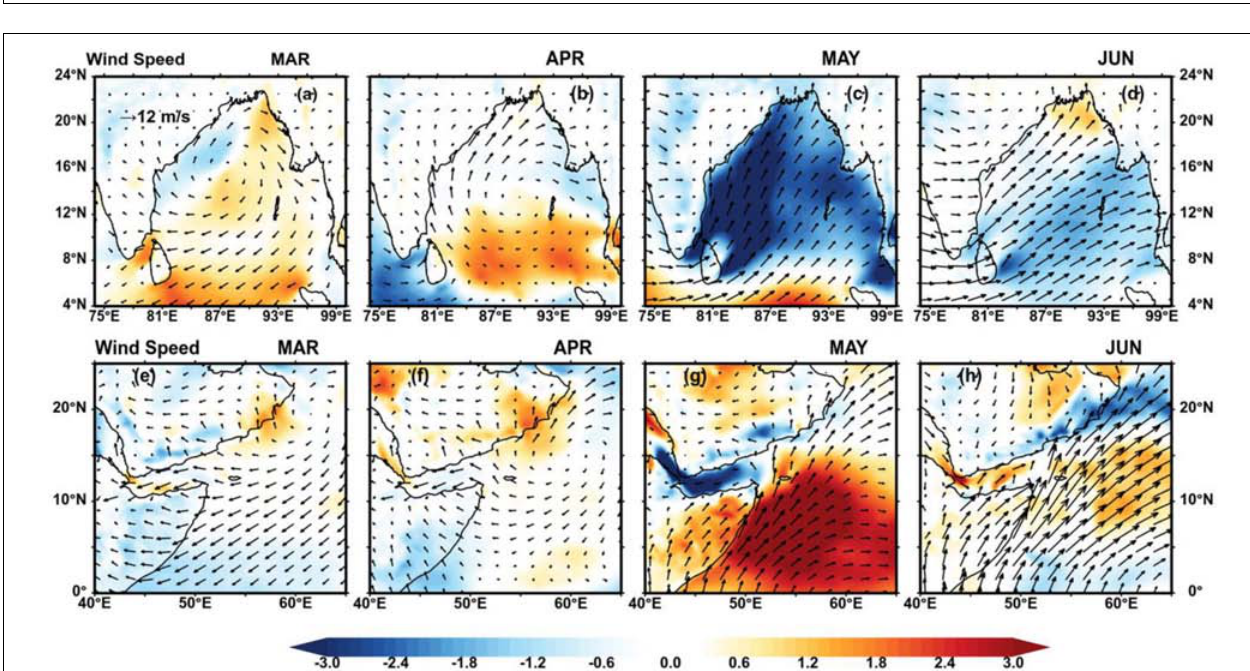
FIGURE 6 | Difference of wind speed (shaded, in meter per second) over the BoB (A–D) and WAS (E–H) for the year 2020 to 2019 (i.e., pandemic – pre-pandemic period) overlaid with climatological mean (2013 to 2020) wind vectors for respective months derived from ERA5 reanalysis data.